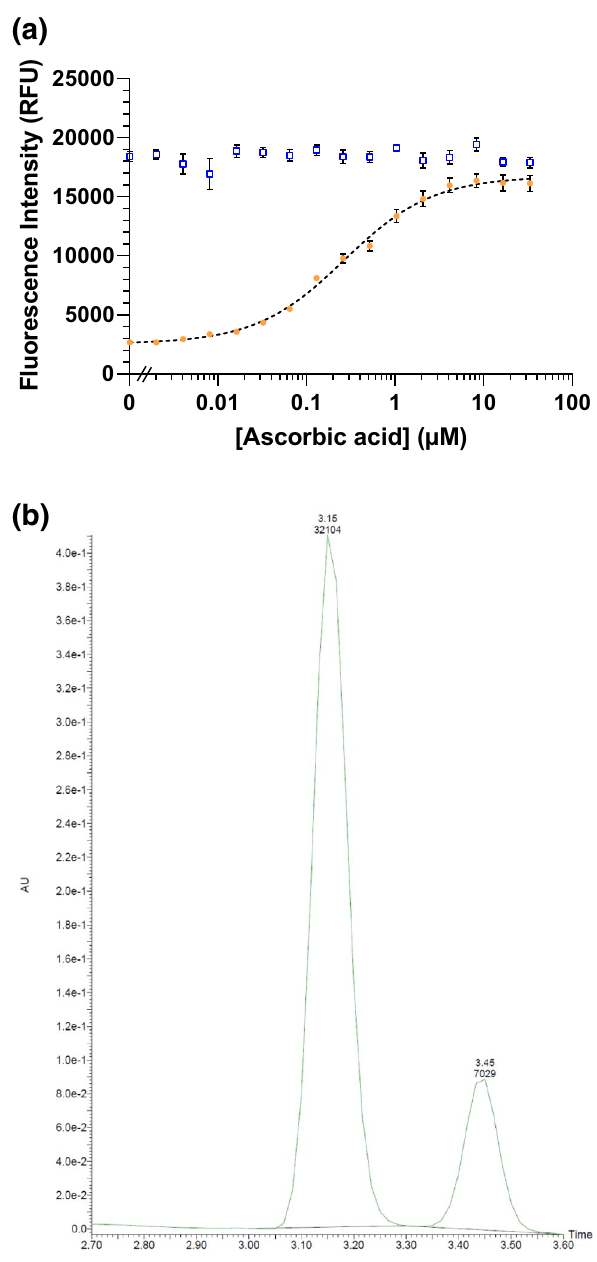
Figure 7. Inhibition of thiaminase I-mediated thiamine degradation in the presence of ascorbic acid. ( a ) Fluorescence intensity measurements using 10 µM thiamine, 1 mM pyridoxine, and ascorbic acid (0–100 µM) incubated in the presence (orange circles) and absence (blue squares) of 0.33 µg/mL thiaminase I at 37 °C for 1 h. 5 µL of the reaction mixture was diluted with 45 µL water, then 100 µL alkaline potassium ferricyanide was added prior to measurement using 360/40 nm excitation, 450/50 nm emission. Each point is the average of the fluorescence values in triplicate with standard deviation represented by the error bars. A 4-parameter logistic equation was used to fit the data (dotted line) from the thiaminase incubations. ( b ) chromatograms showing the formation of the pyridoxine-pyrimidine adduct at 3.45 min and loss of thiamine (3.30 min) under conditions listed above in ( a ) in the absence and ( c ) presence of 100 µM ascorbic acid. ( d ) The kinetics of thiamine degradation obtained using endpoint fluorescence intensity measurements at ascorbic acid concentrations ranging from 0 to 12.5 µM from 15 min to 4